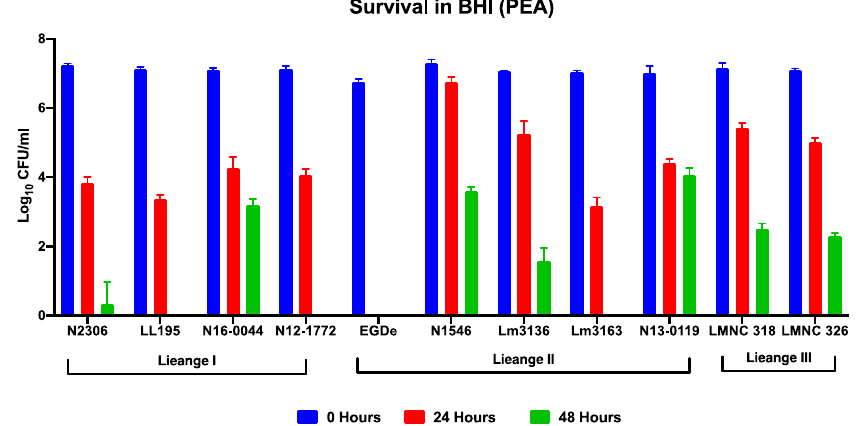
Figure 2. PEA has bactericidal activity against L. monocytogenes . Survival rates of a representative selection of 11 L. monocytogenes strains determined after 24 and 48 h of exposure to PEA MIC in BHI at 37 °C. Presented data show mean log 10 colony forming units (CFU) counts (bars) and standard deviation of three biological replicates at 0 (start of incubation), 24 and 48 h of incubation at PEA MIC. For all strains, there was a significant difference between cell counts at each of their respective sampling time points at p < 0.05 according to one-way ANOVA and Tukey post-hoc test pairwise comparison of all the treatment conditions.